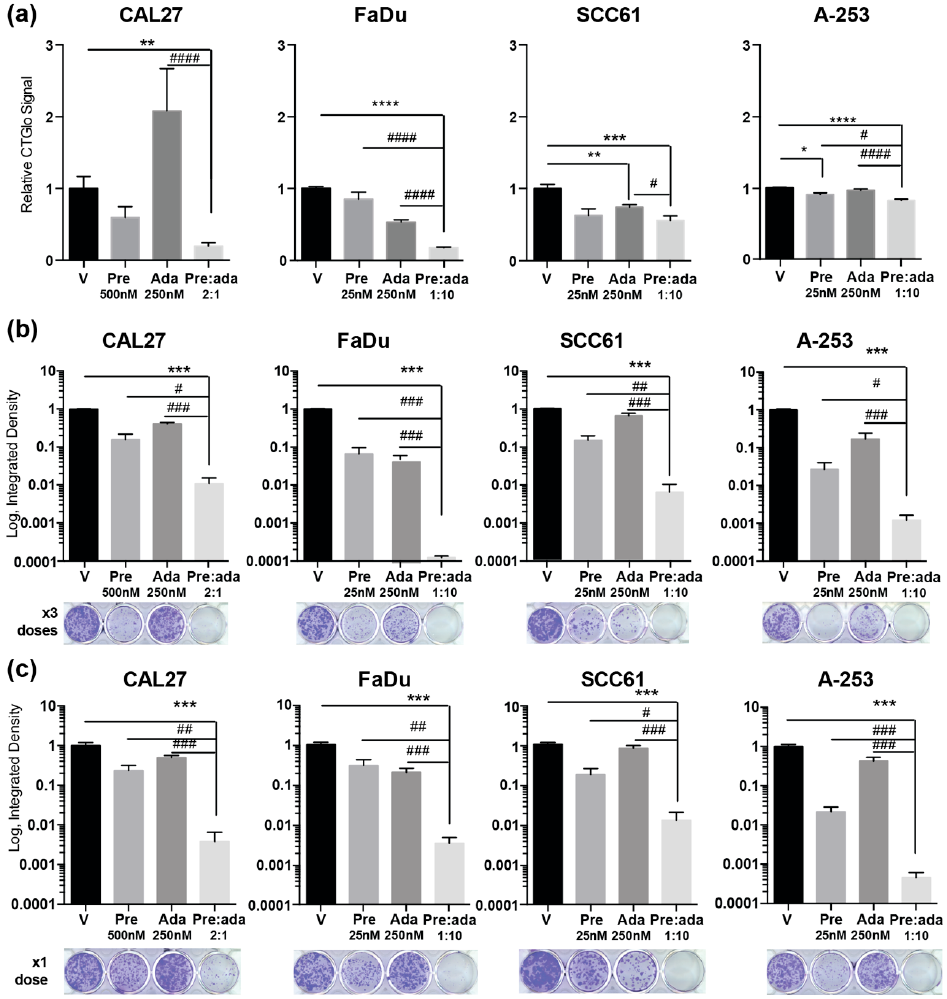
Figure 3. Combination of adavosertib and prexasertib in assays for anchorage-independent growth and clonogenic survival. ( a ) Metabolic activity measured by CellTiterGlo in cells grown in anchorage-independent conditions for 72 h of treatment with vehicle or indicated drugs; ( b, с ) quantification and representative images for clonogenic growth after 12 days of treatment with drugs indicated, either followed by replenishment of drugs at 3-day intervals ( b ), or with cells receiving only a single initial dose ( c ). All graphs: * or #, p ≤ 0.05; ** or ##, p ≤ 0.01; *** or ###, p ≤ 0.001, **** or ####, p ≤ 0.0001 relative to indicated comparator. We note that NHTBE cells must be grown under specialized conditions, at an air-medium interface, and hence cannot be used for a clonogenic assay; further, because they are highly migratory, IMR90 cells do not form colonies; see Figure S2 for further analysis.